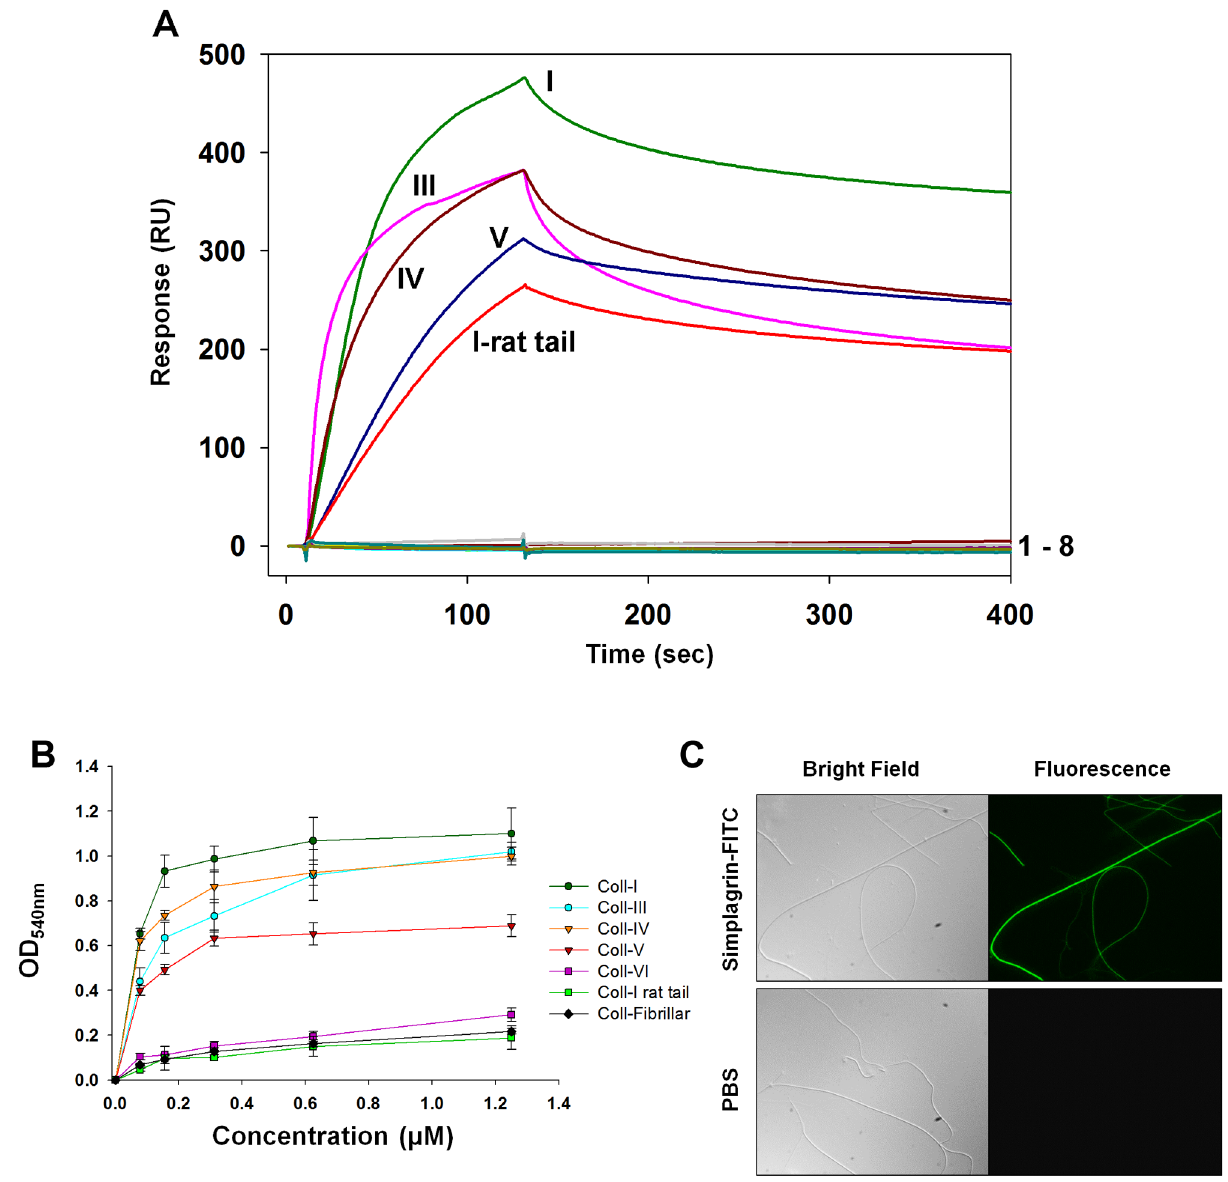
Figure 3. Simplagrin specifically binds to collagen. (A) Surface plasmon resonance: initial screening over immobilized Simplagrin, showing it exclusively binds to collagen (human type I, III, IV, V, and type I from rat tail). No detectable binding was observed to (1–8) coagulation factors IIa, Va and Xa, vitronectin, laminin, fibronectin, vWf, and fibrinogen. (B) Solid-phase assay shows that Simplagrin binds to immobilized collagens on 96 well plates. Binding was detected by ELISA using rabbit anti-Simplagrin antibodies. (C) Visualization of Simplagrin collagen interaction. Fluorescent microscopy showing direct binding of FITC labeled Simplagrin on coverslip coated with fibrillar collagen. Collagen coated coverslips were incubated with 1 m M of FITC labeled Simplagrin for 15 minutes and then washed 5 times with PBS before mounting. Collagen fibrils revealed by bright-field and fluorescence shows that it lacks of autofluorescence.